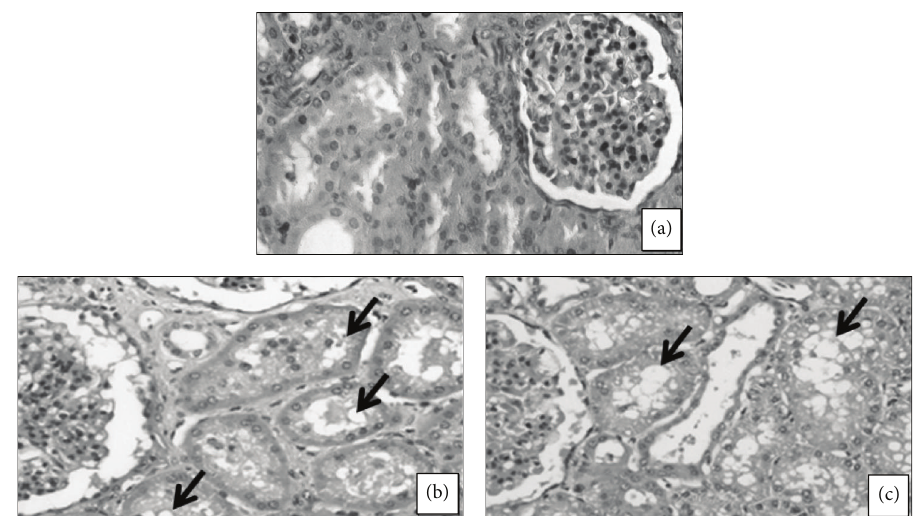
Figure 4: Light photomicrograph of pregnant sows kidney: (a) animal from control group; ((b) and (c), resp.) animals treated with 2.0 and 6.0 mg/kg of body weight of cyanide from day 21 of pregnancy to 110 term showing vacuolar degeneration of the renal tubular epithelium (arrow; (b) and (c)). Magnification: × 20,